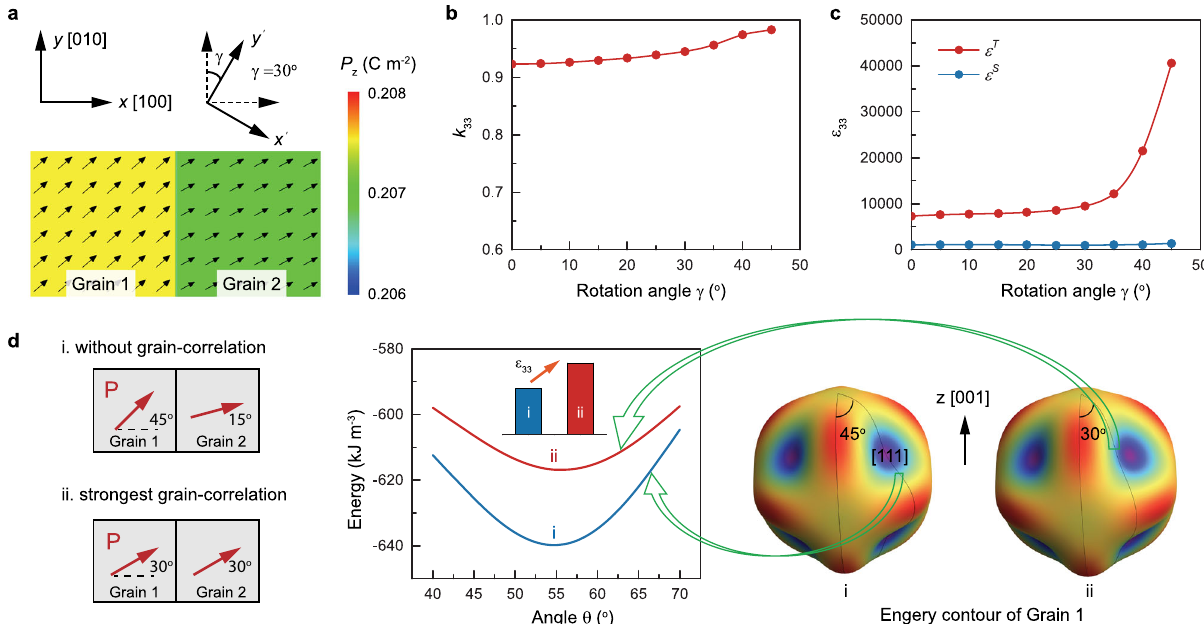
Fig. 2 Grain-correlation effect on k33 determined by phase- fi eld simulation and Landau theory. a Polarization structure for a two-grain ferroelectric system, where the grain orientations are illustrated by the axes. b Simulated k 33 as a function of rotation angle γ between the orientations of two grains. c Simulated permittivity ε T and ε S as a function of rotation angle γ , where the electric fi eld is applied along [001] direction. d Illustration of the grain- correlation effect on the permittivity based on the Landau theory: grain-correlation will make the polarization rotation path deviate from its equilibrium point and hence fl attens the energy pro fi le, which increases the permittivity ε T and eventually enhances k 33